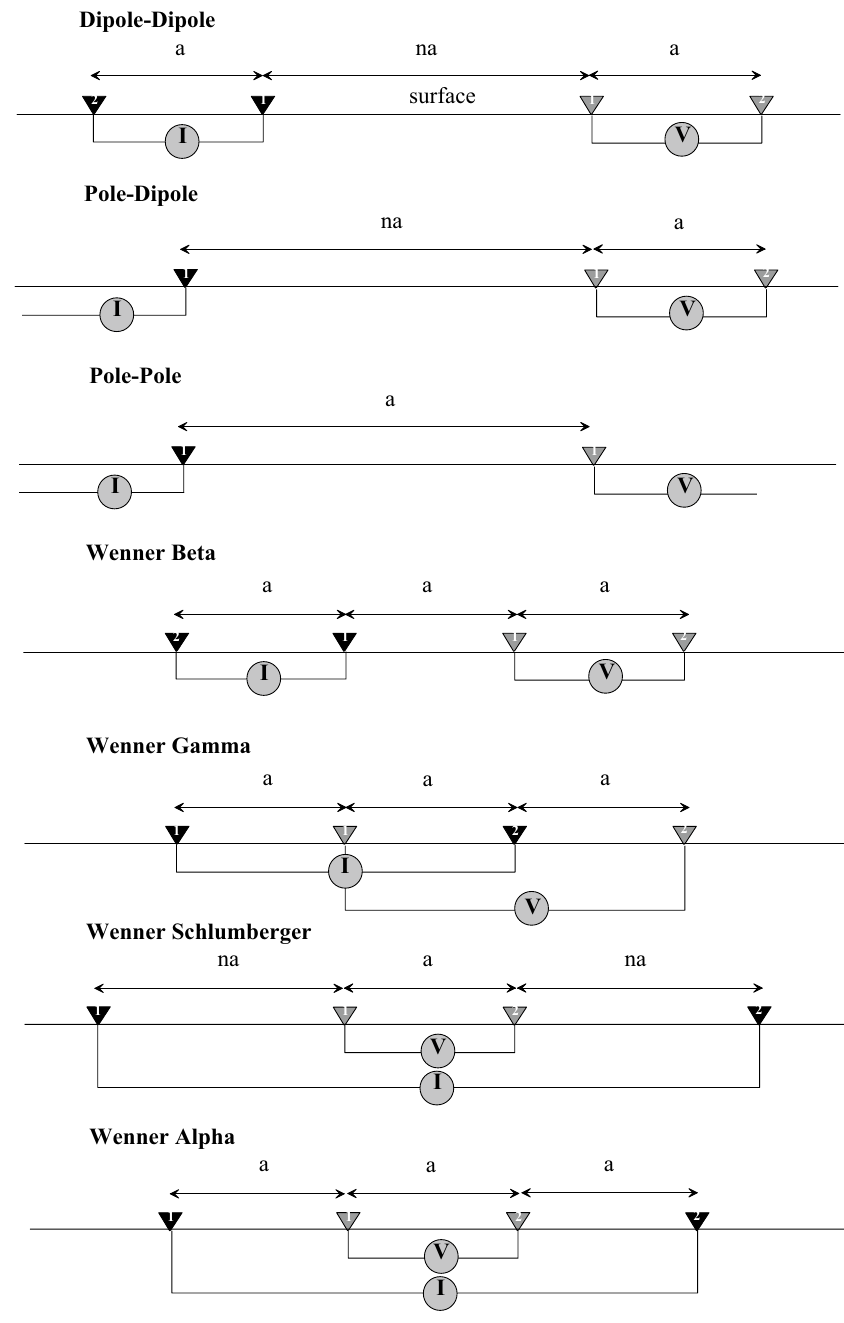
Fig. 3 Frequently used arrays for 1D, 2D, 3D Electric imaging and